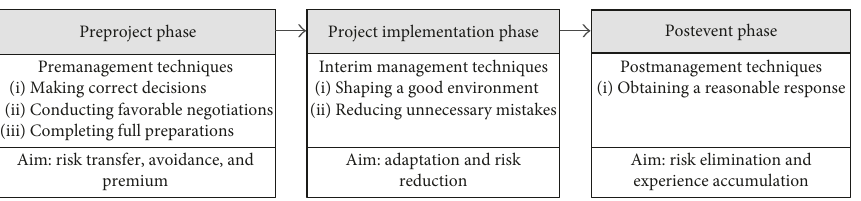
Figure 2: Application of the components.